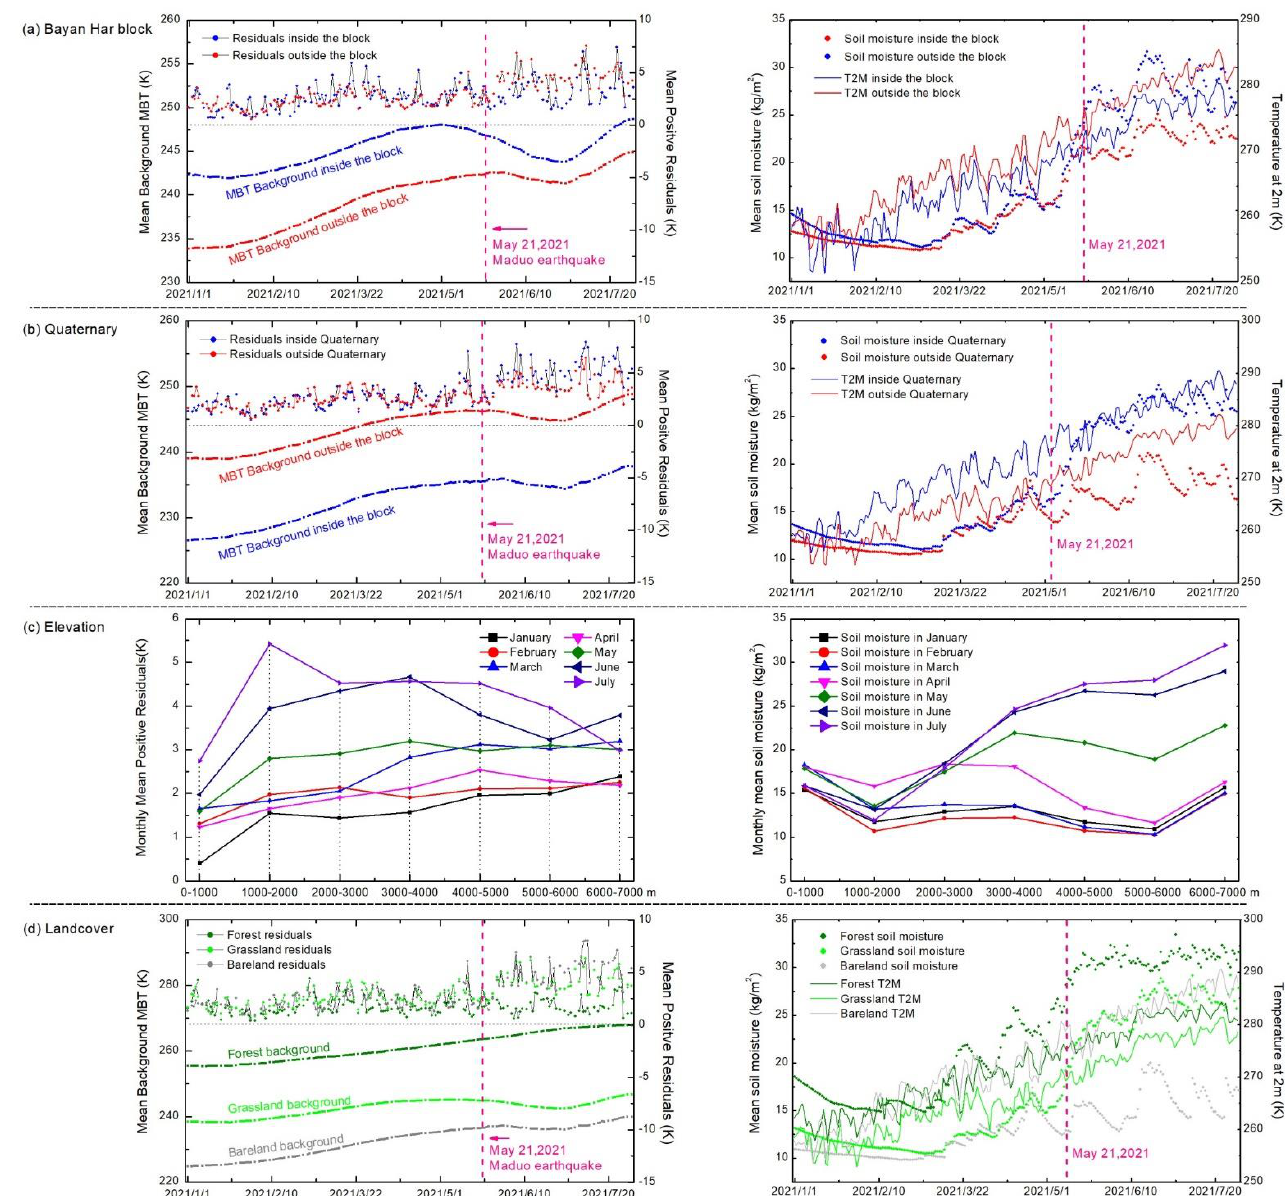
Figure 7. Time series of background MBT and average MBT positive residuals with 10.65 GHz at H polarization (left), soil moisture and air temperature (right), inside and outside the Bayan Har block ( a ), in and outside the Quaternary regions ( b ), of different elevation intervals ( c ), and in different landcover regions ( d ).